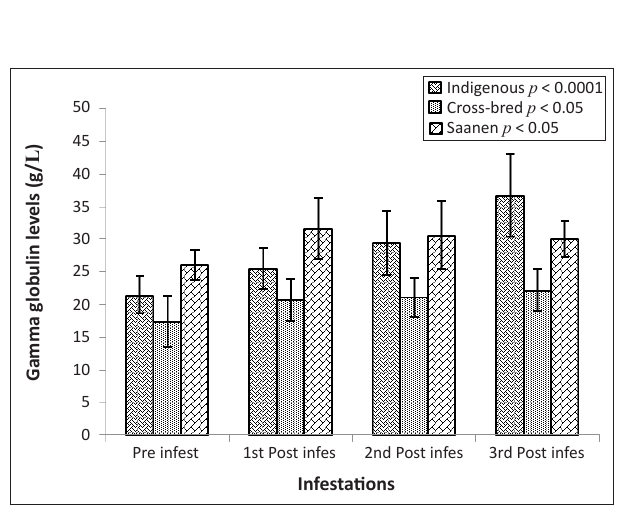
FIGURE 1: Increase in gamma globulin levels (g/ L ) in South African Indigenous goats (Nguni), cross-bred goats and Saanen goats before and after three consecutive infestations of Rhipicephalus appendiculatus adult ticks.